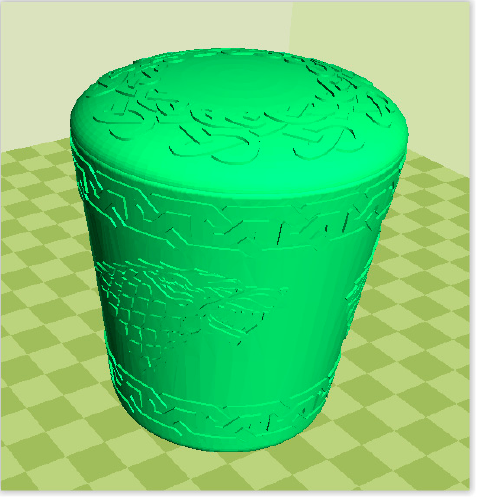
Figure 1. Cura rendering of details of freely available design of a Game of Thrones dice cup.